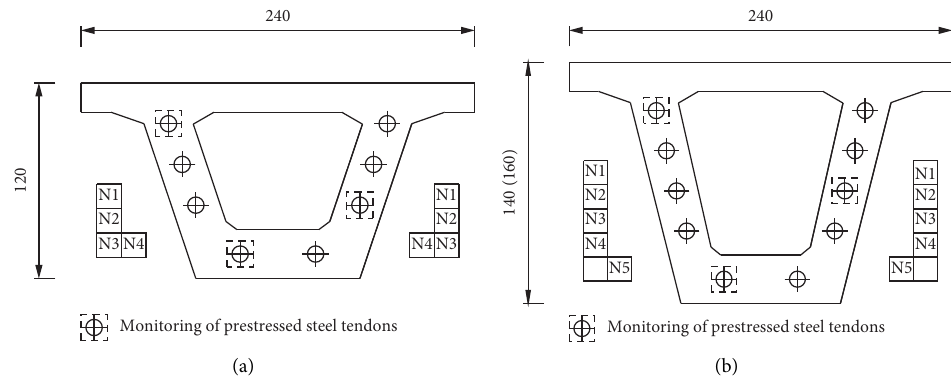
Figure 1: Monitoring of prestressed steel tendons: (a) 20m box girder; (b) 25m (30m) box girder (unit: cm).